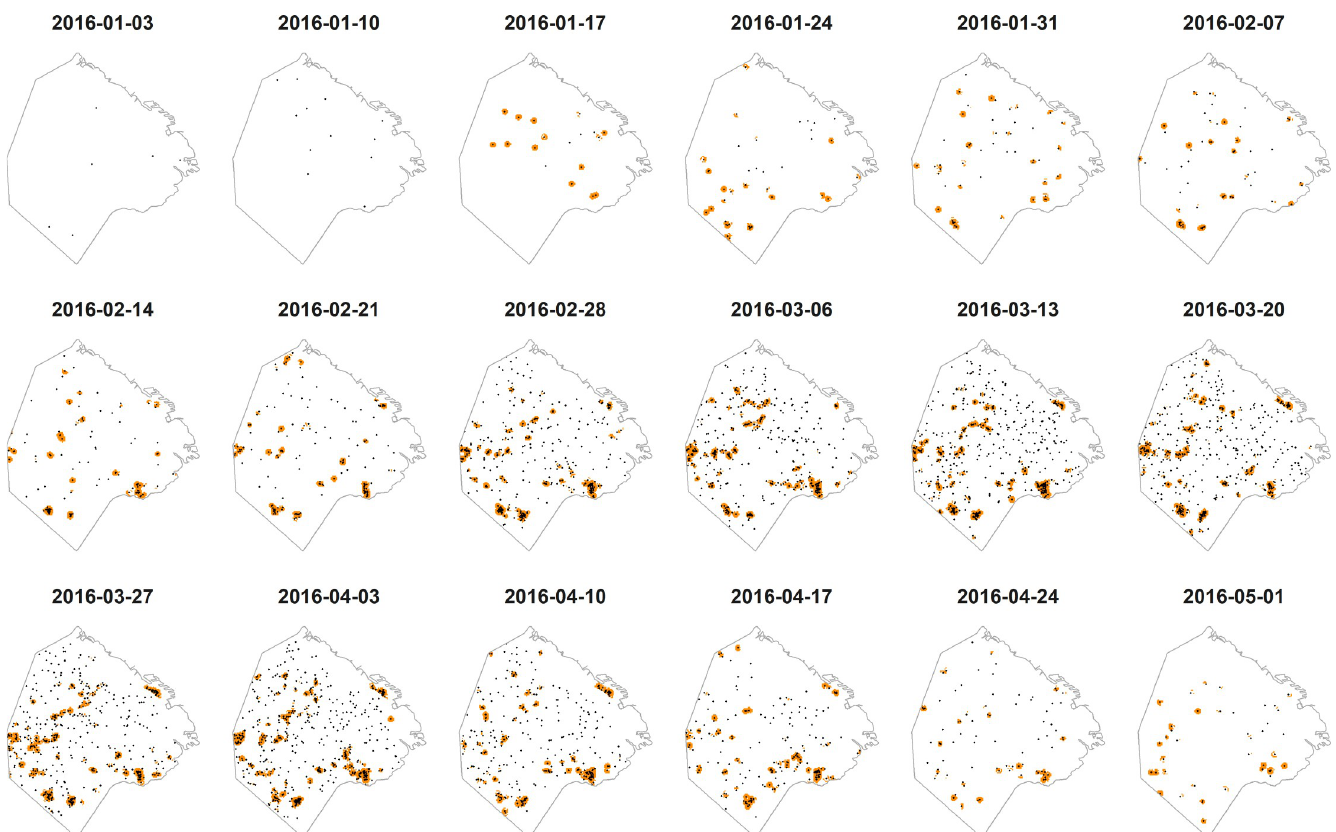
Fig 5. Weekly local spatiotemporal analysis identified multiple dengue transmission foci in Buenos Aires. Foci are indicated by orange areas. Autochthonous cases are displayed as black points. The displayed dates indicate the beginning of the corresponding week. The time window considered encompassed only the current week (i.e., τ = 0), with a radius of 300 m. Map base layer downloaded from the open-data repository of the Government of the City of Buenos Aires (https://data.buenosaires. gob.ar/dataset/informacion-censal-por-radio).